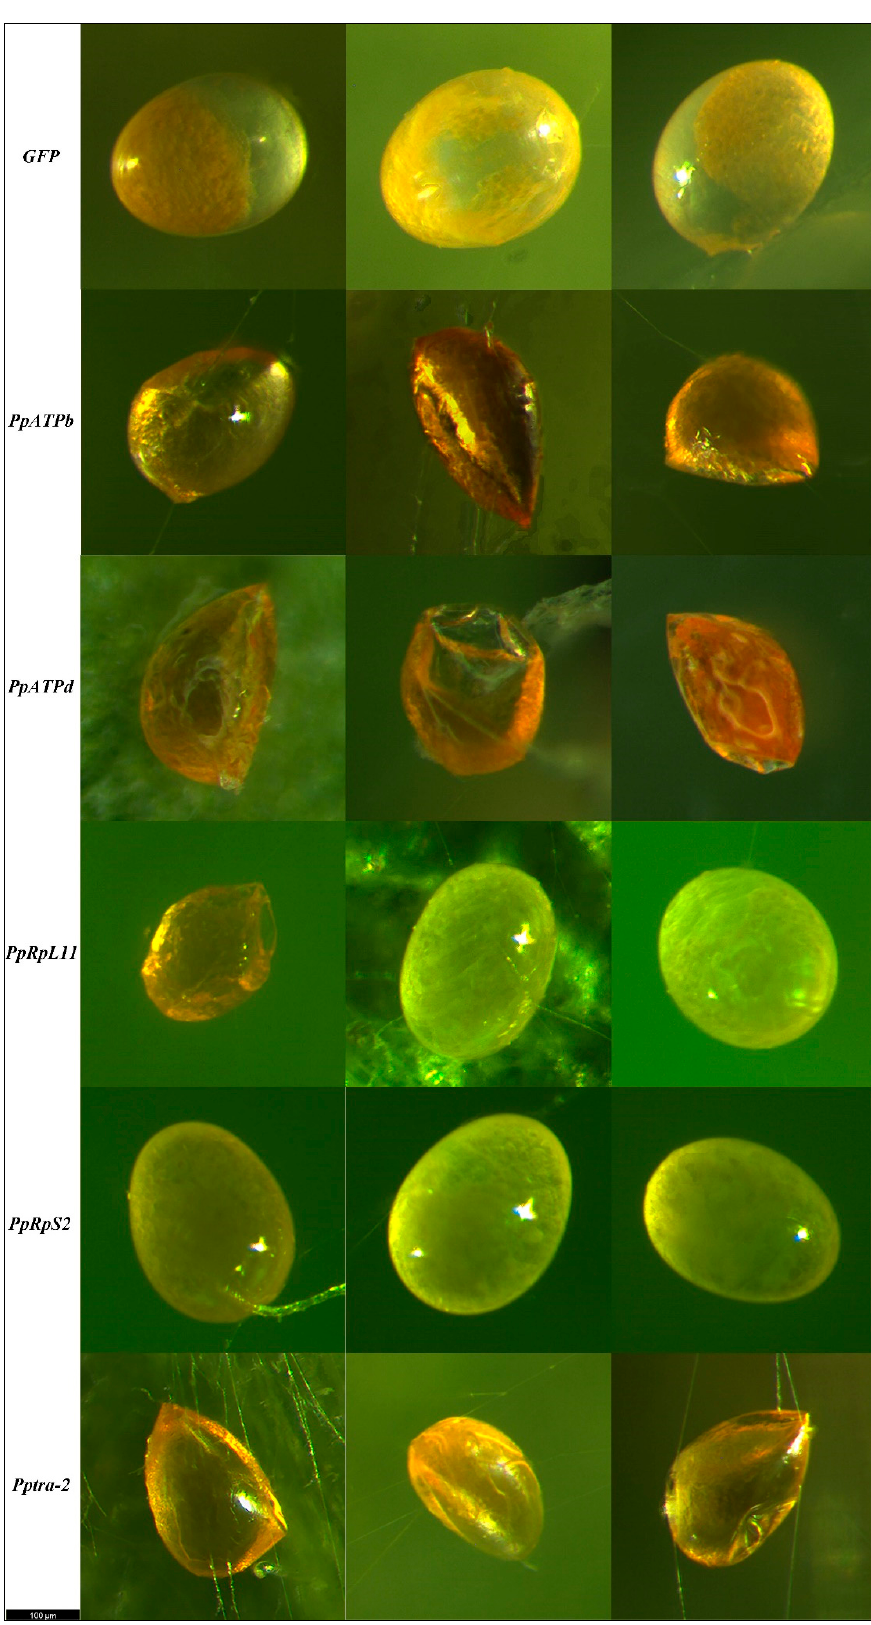
Figure 5. Morphology of normal P. persimilis eggs (laid by females interfered with GFP) and unhatched eggs laid by females had each of the five genes interfered. When the mother had PpATPb and